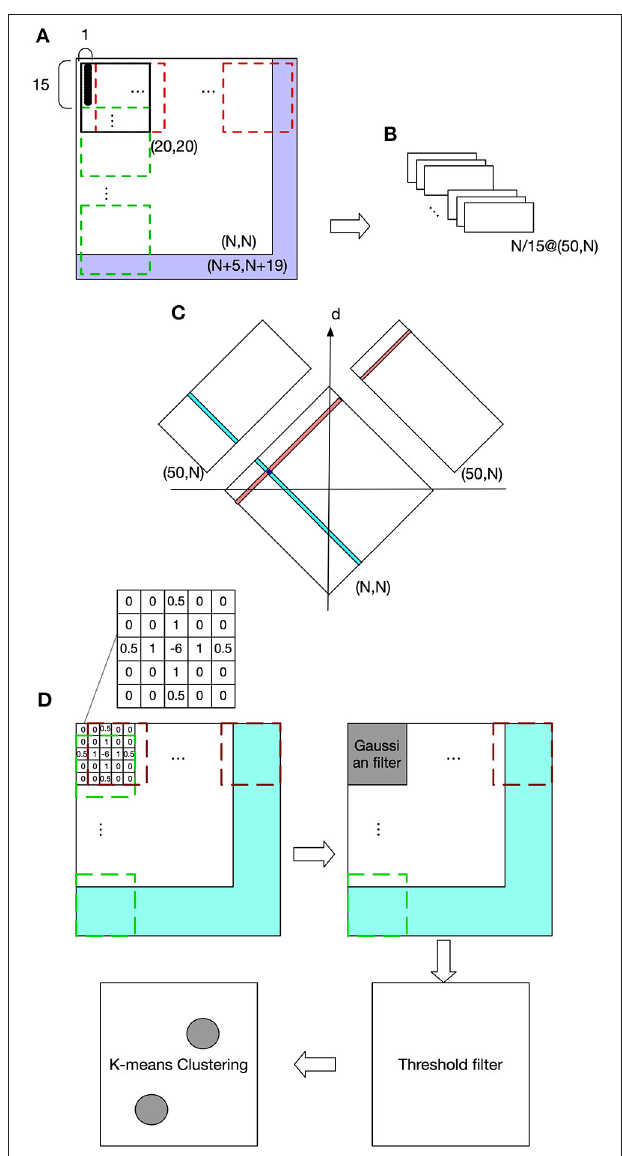
FIGURE 2 | Visual processing. (A) The purple area shows zero pads. The red dashed frame indicates transformer’s spatial extent along columns and the green dashed frame along rows. (B) Spatial frequency response maps (SfRM) with size of (50, N). Each row of UA is projected to a SfRM, within which each column is the frequency response of an UA. Therefore, a LumM possessing N/15 rows and N columns of UA creates N/15 SfRM in size of (50, N). A SfRM has 50 rows because 50 frequency responses are obtained, and N columns come from the corresponding N columns of UA. (C) Binocular correspondence map (BCM). Frequency-based comparisons determine the correspondence relations between the left and right UAs, and also their depth. (D) Spatial localization of the target object and the end-effector.